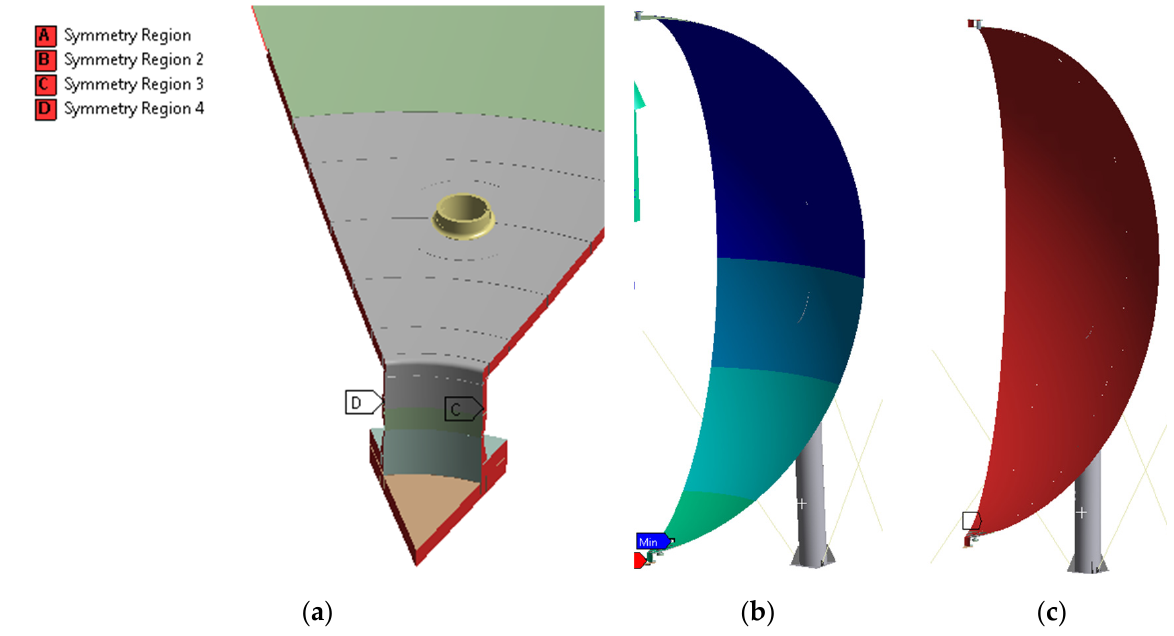
Figure 4. ( a ) Symmetry conditions applied to the 1/9 liquid nitrogen tank model, ( b ) hydrostatic pressure exerted by liquid nitrogen to the internal surfaces of the 1/9 liquid nitrogen tank model, ( c ) pressure from gases located above the liquid nitrogen mirror applied to the surface of the 1/9 liquid nitrogen tank